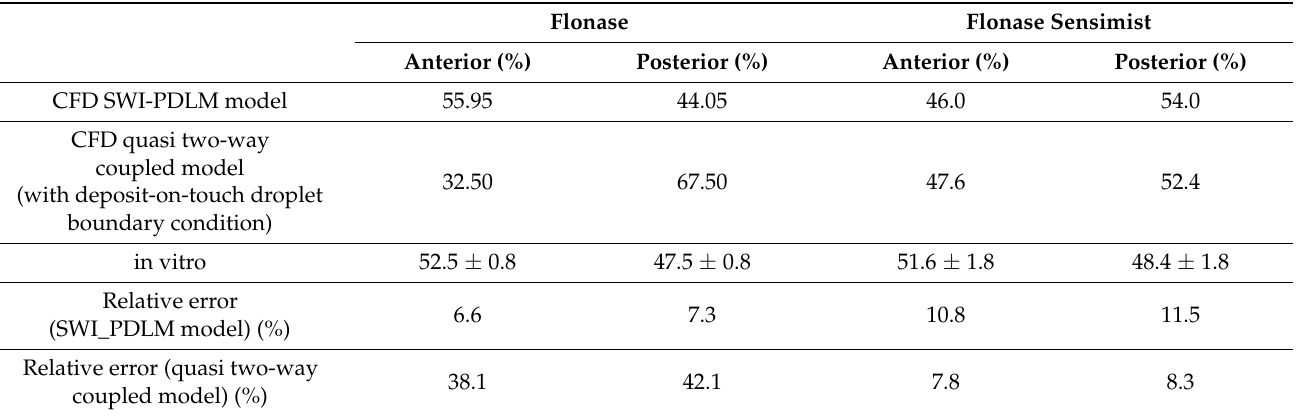
Figure 6. Comparison of the Flonase ( a ) and Flonase Sensimist ( c ) spray deposition prediction by the quasi two-way coupled Lagrangian model and the SWI-PDLM model with the in vitro measurements. Flonase ( b ) and Flonase Sensimist ( d ) spray droplet deposition locations predicted by the quasi two-way coupled Lagrangian model. Table 3. Comparison of CFD predicted spray deposition in specific nasal regions using the SWI-PDLM and the quasi two-way coupled models with the in vitro